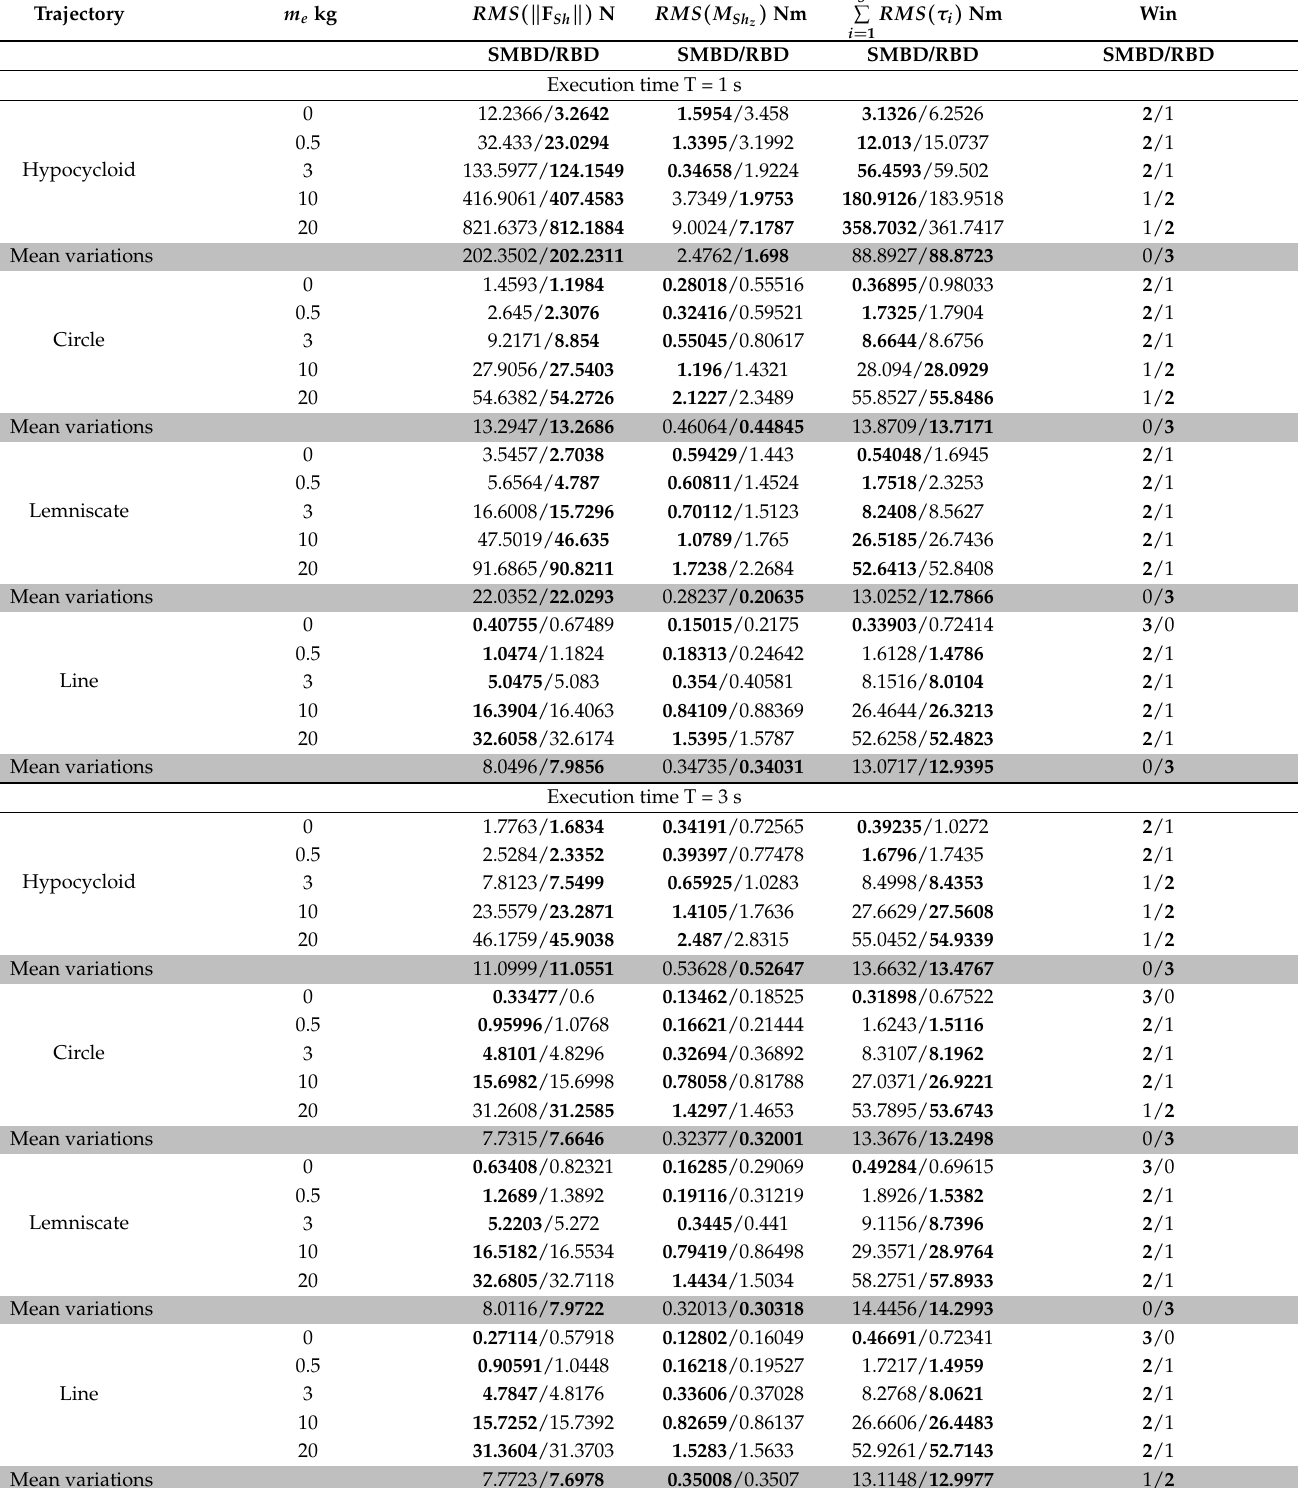
Table 10. Comparative results of the RBD with respect to the SMBD with different tasks, speeds, and end-effector